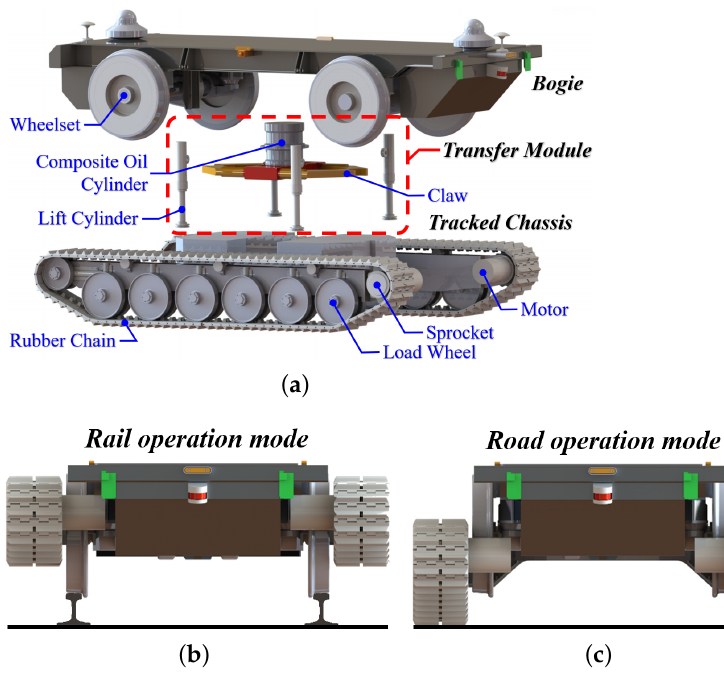
Figure 1. Proposed road-rail vehicle ( a ) general view ( b ) rail operation mode ( c ) road operation